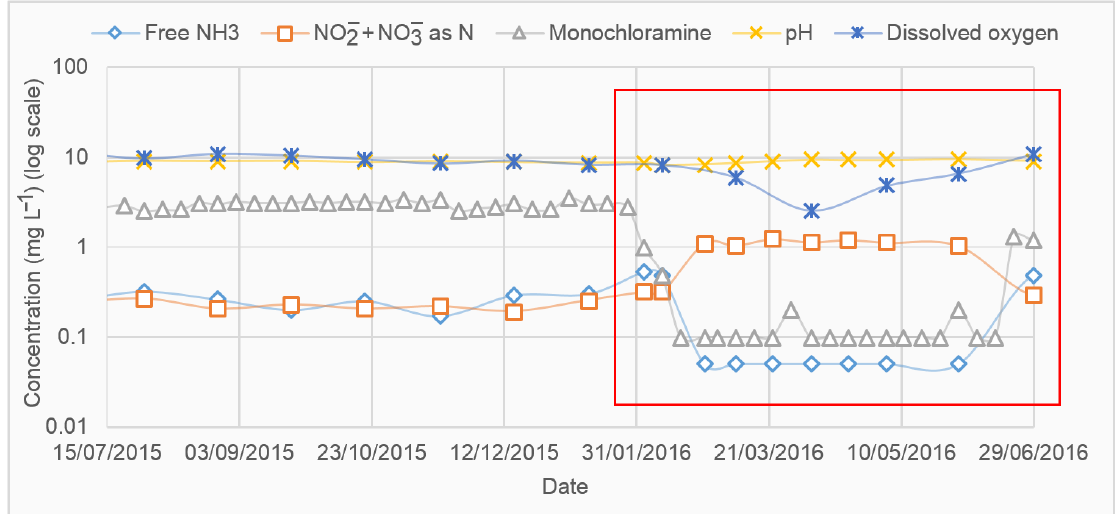
Figure 3. Water quality changes during a nitrification episode in a DWDS in South Australia. The plot represents grab samples test data at regular intervals. The left side of the plot indicates usual water quality and no nitrification, while the data within the red rectangle shows a sudden change in water quality during the nitrification event. Monochloramine, free ammonia, and DO levels dropped, while nitrite and nitrate levels increased. The water quality at the end of the plot returned to normal after preventive measures were taken.